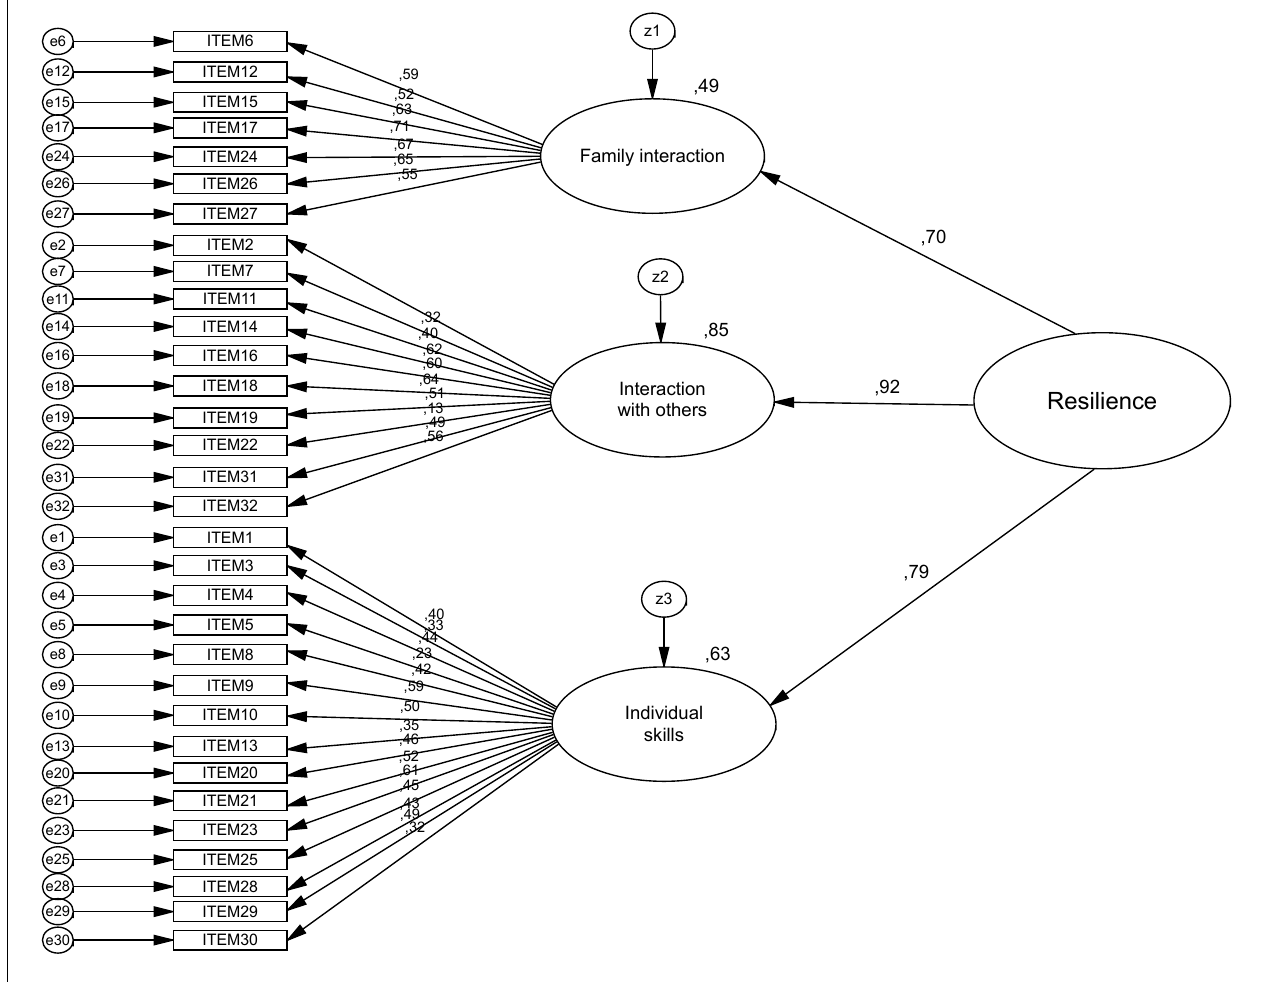
FIGURE 2 | Standardized estimates, as well as the squared multiple correlations for Model